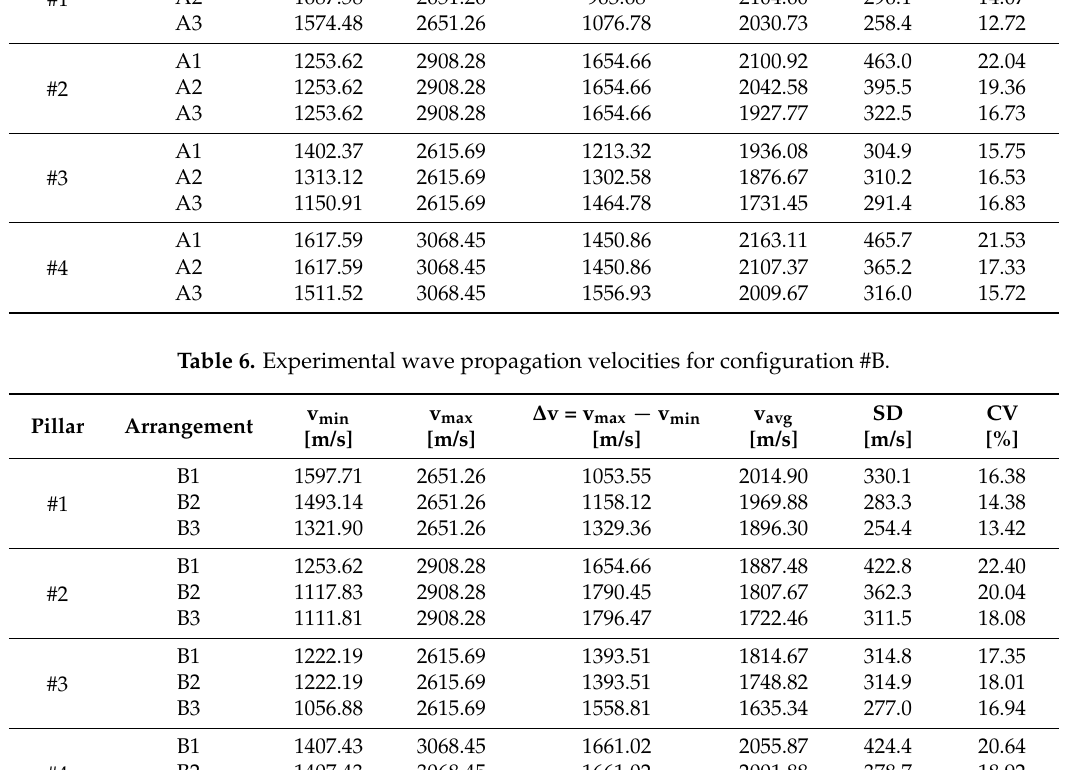
the mortar and bricks. Differences between the velocity of the waves passing through one, two, and three joints were also observed. As in the case of the FEM simulations, the velocity value decreased with the increase of the number of joints on the wave